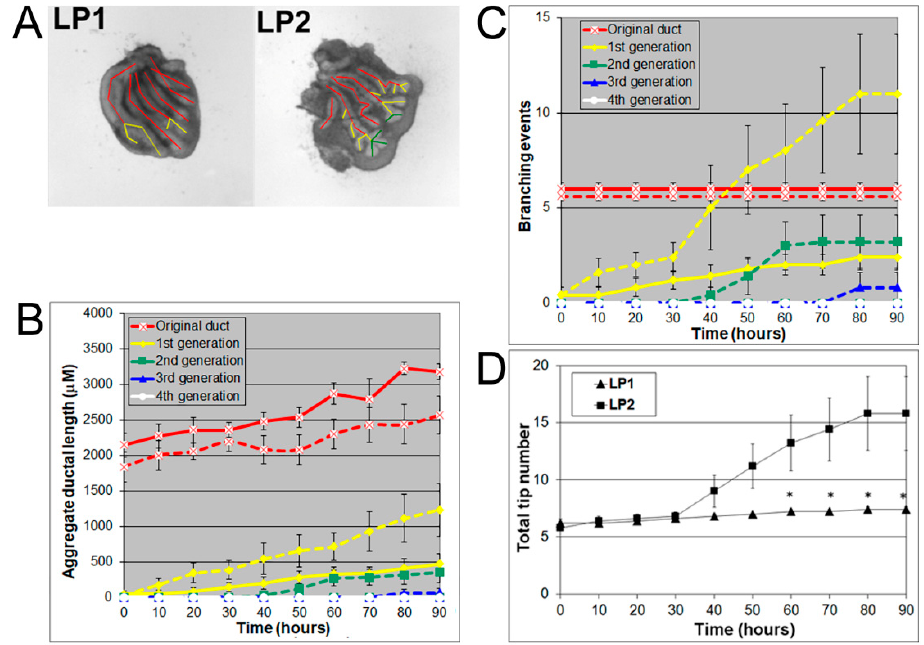
Figure 2. ( A ) Branch generations of cultured contralateral rat day 2 LP1 (left) and LP2 (right) lobes. Successive images were taken every 30 min for 90 h to track branching events. A color-coded skeleton is used to denote the branch generations as described in Figure 1. Representative end-point images are shown at 90 h. Note that LP1s have longer original ducts and formed branches only up to the first generation over the 4-day culture, whereas LP2s have shorter original ducts and formed branches up to the third generation. ( B ) Kinetics of prostatic bud and duct elongation over successive branch generations in pnd 2 rat LP1s and LP2s cultured for 90 h. The aggregate length ( μ m) of all ductal segments in each successive branch generation over time is shown. Solid lines represent data from LP1s, and dashed lines represent data from LP2s. ( C ) Total number of branch point events in each ductal generation as a function of time. Solid lines represent data from control LP1s, and dashed lines represent data from LP2s. Error bars denote SEM from 5 sets of experiments. Differences between the two groups were statistically significant ( p < 0.05) from 20 h onward except for the original ducts. ( D ) Total tip number in 3D analysis as a function of time in rat day 2 LP1s (squares) and LP2s (triangles) cultured for 90 h. Each data point represents the mean of 5 sets of experiments and bar denotes SEM. * denotes significant differences between LP1s and LP2s, p < 0.05.